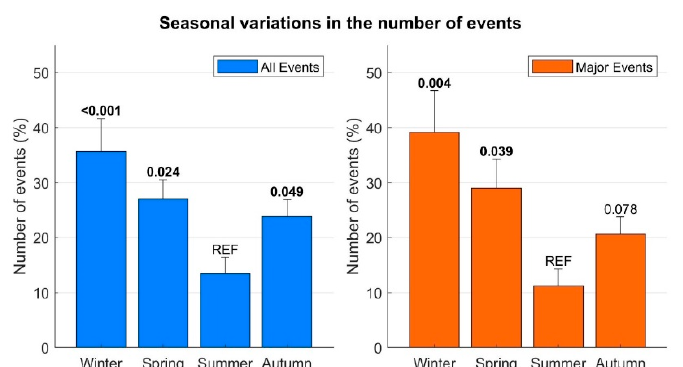
Figure 3. Seasonal distribution of the events. Bars: number of events, averaged across years. Whiskers: standard errors. p -values (Wilcoxon signed-rank test) assessing the difference between number of events registered during winter, spring and autumn with respect to those recorded during the summer (REF) are shown. p < 0.05 is reported in bold.